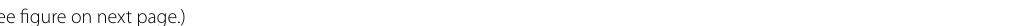
methanol(See figure on next Fig. 1 Expression of RHLC via recombinant P. pastoris . a Sketch map of construction of recombinant P. pastoris GS115 with RHLC gene and followed expressed in shake flask and fermenter. b SDS–PAGE analysis of RHLC prepared by shake flask fermentation with different induction times and induction by methanol. c Wet cell mass (g/L) and protein content (g/L) of RHLC in a 5-L fermenter following induction by methanol. d SDS–PAGE analysis of RHLC in a 5-L fermenter with different induction times and induction by